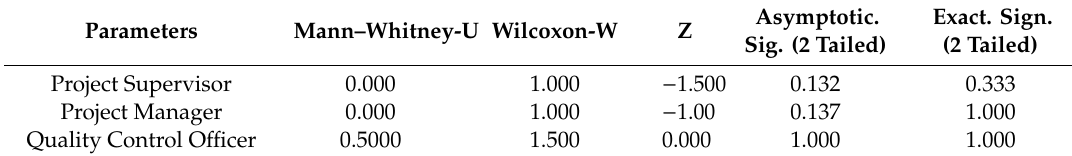
Table 11. Mann–Whitney U test.